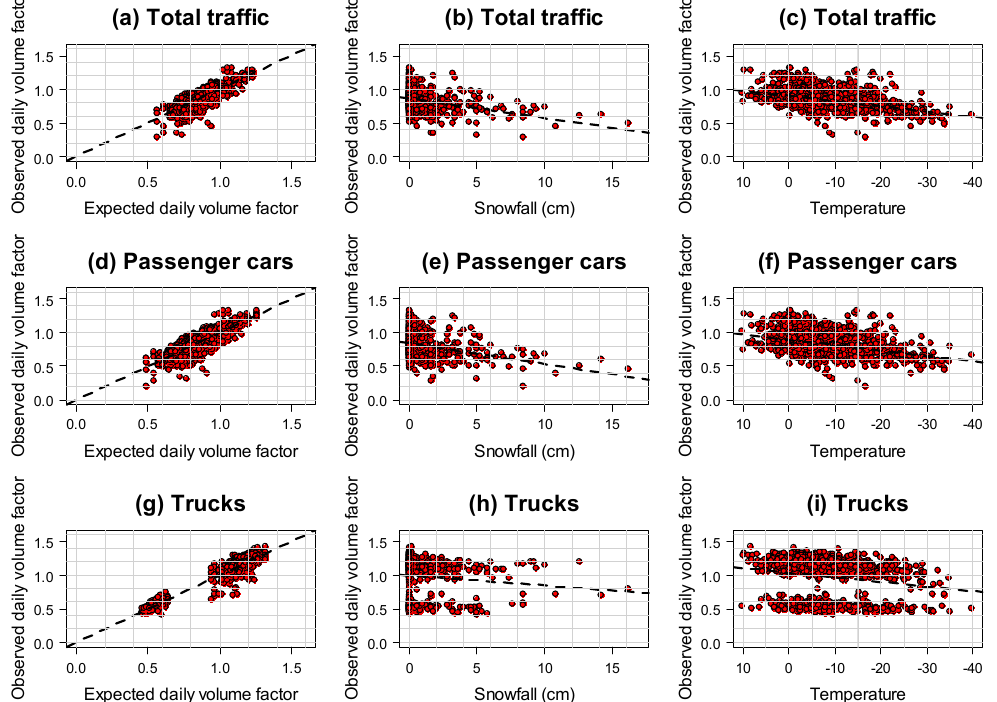
Figure 2. Scatter plots between dependent and independent variables.